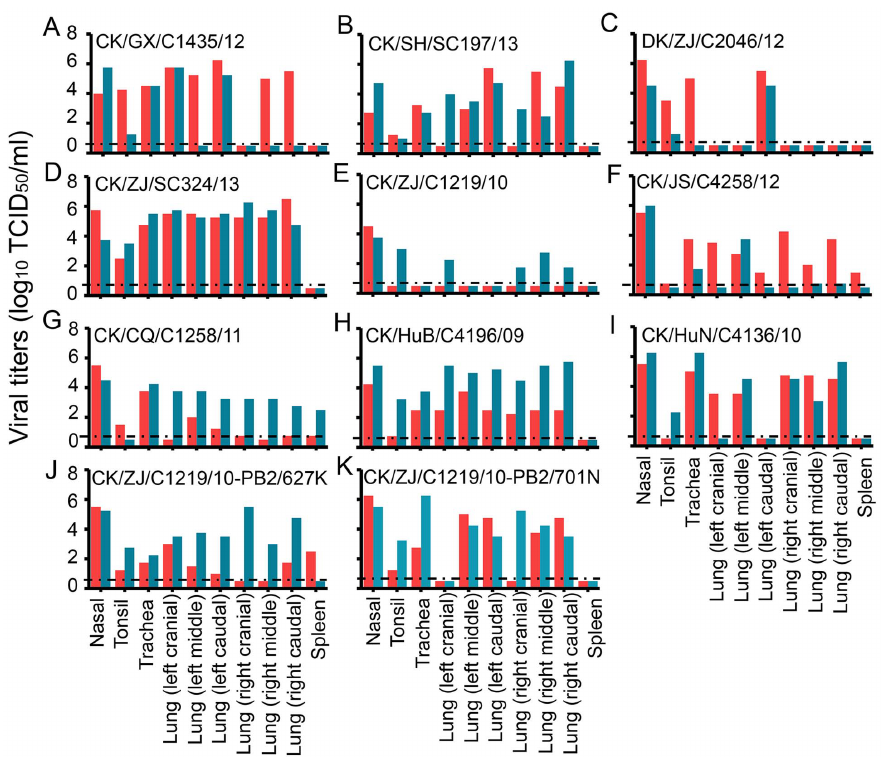
Figure 4. Replication of H9N2 viruses in ferrets. ( A ) CK/GX/C1435/12. ( B ) CK/SH/SC197/13. ( C ) DK/ZJ/C2046/12. ( D ) CK/ZJ/SC324/13. ( E ) CK/ZJ/ C1219/10. ( F ) CK/JS/C4258/12. ( G ) CK/CQ/C1258/11. ( H ) CK/HuB/C4196/09. ( I ) CK/HuN/C4136/10. ( J ) CK/ZJ/C1219/10-PB2/627K. ( K ) CK/ZJ/C1219/10- PB2/701N. Each color bar represents the virus titer from an individual animal. The dashed black lines indicate the lower limit of detection.